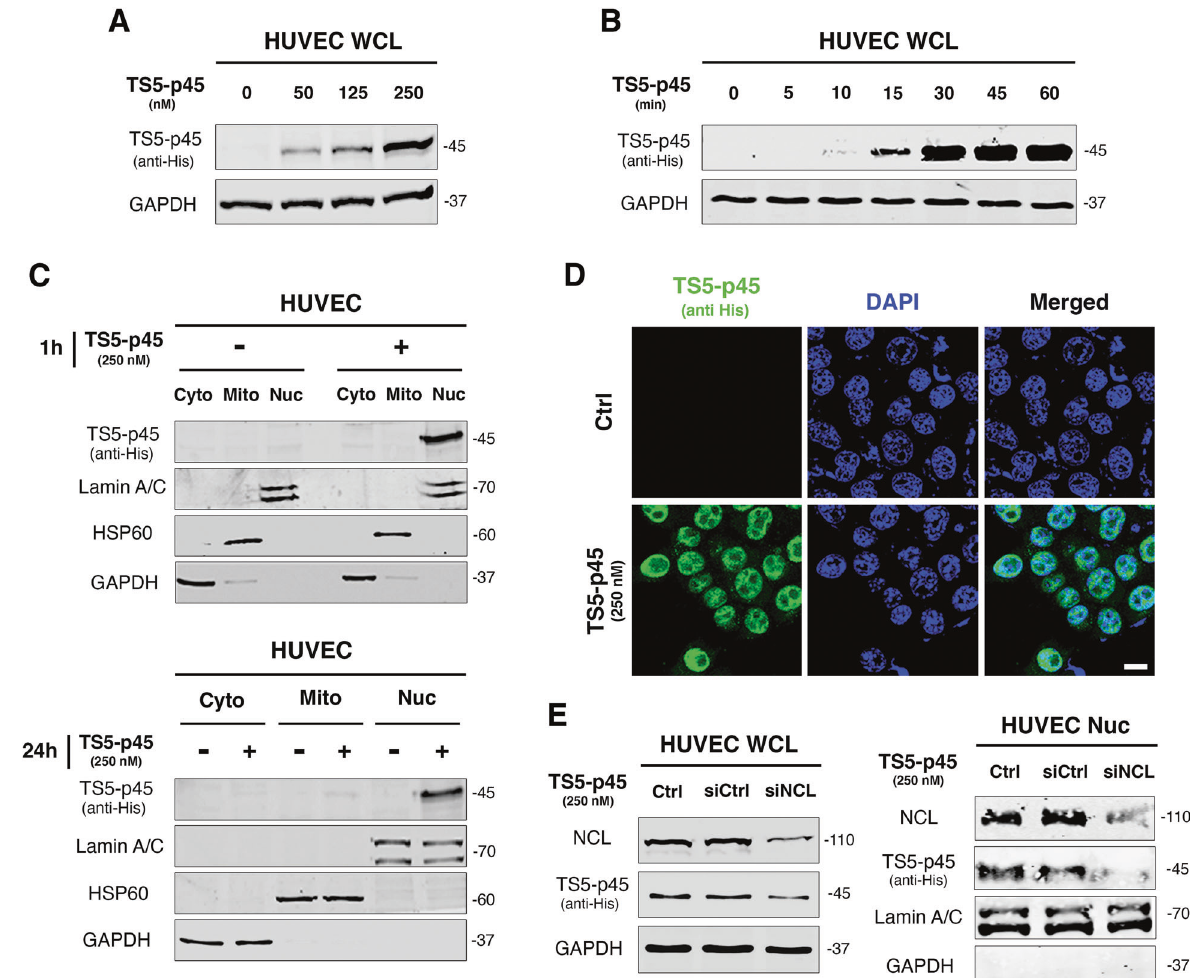
Fig. 4 TS5-p45 is internalized and traf fi cked to the nucleus upon interacting with cell surface NCL. A , B Dose- and time-dependent TS5- p45 internalization into HUVECs; A various concentrations and B various lengths of time, GAPDH was used as a loading control. C , D TS5-p45 was predominantly translocated into the nucleus. C HUVECs treated with TS5-p45 for 1 h and 24 h was fractionated, and TS5-p45 was shown by anti-His blotting. Lamin A/C (Nuc), GAPDH (Cyto), and HSP60 (Mito) were used as loading controls for respective fractions. D HUVECs treated with TS5-p45 were stained by anti-His (TS5-p45, green) and DAPI (Nuc marker, blue). Scale bar represents 200 μ m. E siRNA knockdown of NCL reduced the internalization and nuclear translocation of TS5-p45. siNCL-transfected HUVECs were treated with TS5-p45 and fractionated into WCL and Nuc fractions. Endogenous NCL levels in WCL and Nuc fractions were analyzed by anti-NCL blotting. GAPDH (Cyto) and Lamin A/C (Nuc) were used as loading controls. pathways, including clathrin-dependent, caveolin-dependent, and after 1 h of incubation with ECs, with very little of it detected in the macropinocytosis. Clathrin- and caveolin-dependent pathways cytosol (Cyto) or mitochondria (Mito). At 24 h post-treatment, TS5- p45 remained in the nucleus (Fig. 4C). The purity of the subcellular fractions was con fi rmed by using various markers, including Lamin A/ C for Nuc, HSP60 for Mito, and GAPDH for Cyto (Fig. 4C). Immuno fl uorescence staining further con fi rmed the ef fi cient nuclear traf fi cking of TS5-p45 after 1 h of interaction with ECs (Fig. 4D). To reveal if the internalization and nuclear traf fi cking of TS5-p45 are dependent on cell surface NCL, we knocked down NCL with siRNA and incubated siNCL-transfected HUVECs with TS5-p45 for 1 h. As shown in Fig. 4E, upon knockdown of NCL, TS5-p45 internalization and nuclear traf fi cking are both signi fi cantly hindered TS5-p45 internalization (Fig. 5C), suggesting that both reduced. These results indicate that cell surface NCL mediates clathrin- and caveolin-dependent endocytosis pathways are the internalization and nuclear traf fi cking of extracellular TS5-p45. involved in mediating TS5-p45 internalization. We then investigated the role of the endosomal protein Intact late endosomes (LEs) are required for nuclear traf fi cking pathway using an endosomolytic peptide L17E, a traf fi cking and pro-apoptotic activity of TS5-p45 cationic amphiphilic peptide with speci fi c membrane lytic To understand the signi fi cance of the internalization for the pro- activity for LEs. Adding L17E into cell culture media will lead apoptotic activity of TS5-p45, we inhibited various endocytosis